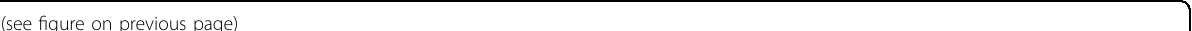
Fig. 6 Spatially resolved determination of the expression of candidate genes, the activity of HCM-related pathways, and the distribution of subpopulations by spatial transcriptomics. a H&E staining image for the cardiac tissue section HCM1225D. b Masson ’ s trichrome staining image of a section adjacent to HCM1225D. c UMAP plot showing the spot clusters identi fi ed using unbiased clustering of the spots on HCM1225D. d Distribution of the spot clusters on the HCM1225D section. e Spatial location of the subpopulations FB1, FB2, CM1, and CM2 on the HCM1225D section predicted by integrating snRNA-seq data and spatial transcriptomic data. f Expression distribution of representative markers and candidate target genes on the section HCM1225D. g Dysregulated pathways in fi brotic versus non- fi brotic regions of the cardiac tissue sections of HCM. The dysregulated pathways were identi fi ed based on the pathway activity scores of each spot using the Wilcoxon rank-sum test. The signi fi cance threshold was set to a Bonferroni-adjusted P -value < 0.05 and an absolute of the log2 fold change > 0.25. HCM1220B and HCM1220C are sections from different samples of the same patient; HCM1406B and HCM1406C are neighboring sections from the same patient. h Activity of representative upregulated pathways in fi brotic regions on the HCM1225D